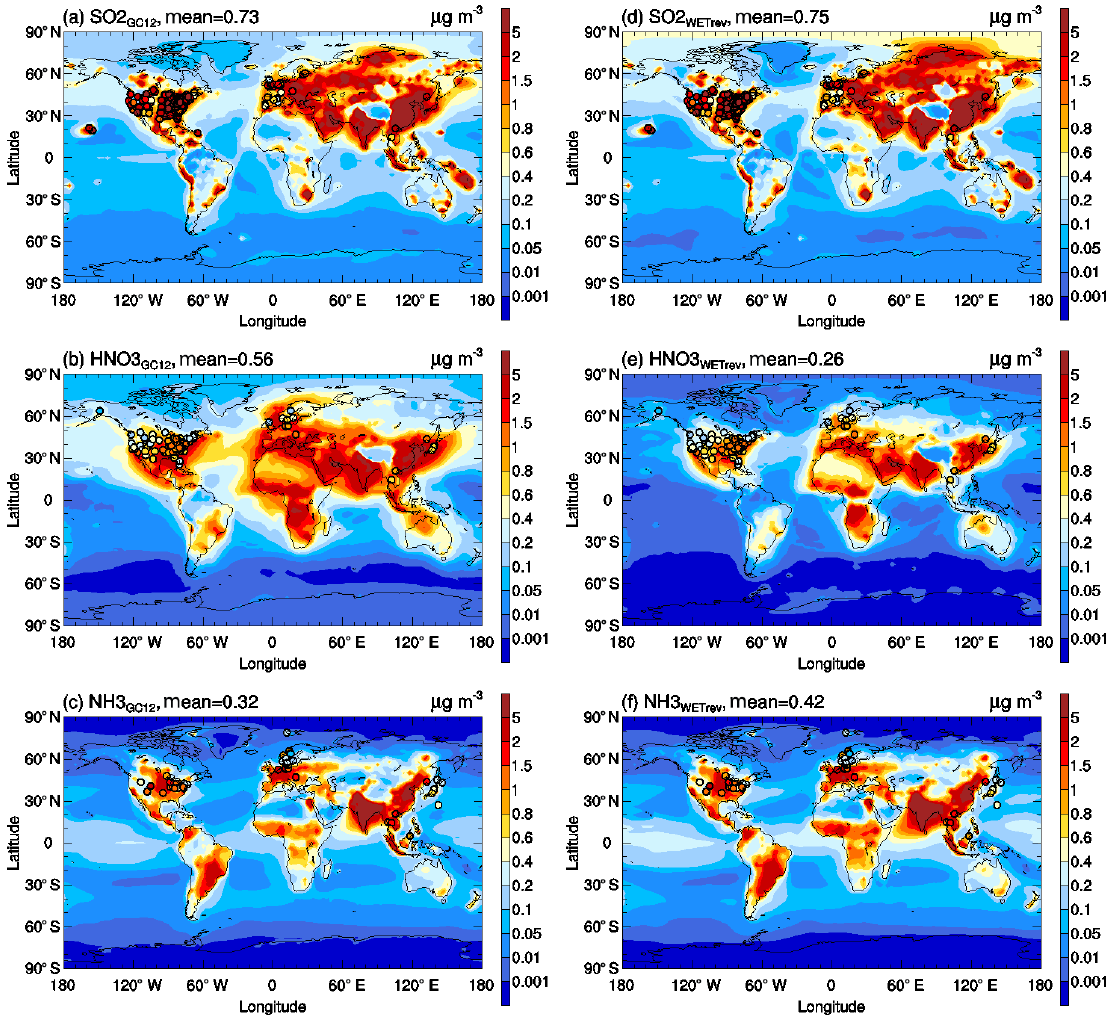
Figure 10. Horizontal distributions of SO 2 , nitric acid, and ammonia surface mass concentrations simulated by the (a–c) GC12 case and (d–f) WETrev case. Filled circles are annual mean surface mass concentrations observed at IMPROVE, CSN, CASTNET, AMoN, EMEP, and EANET for corresponding